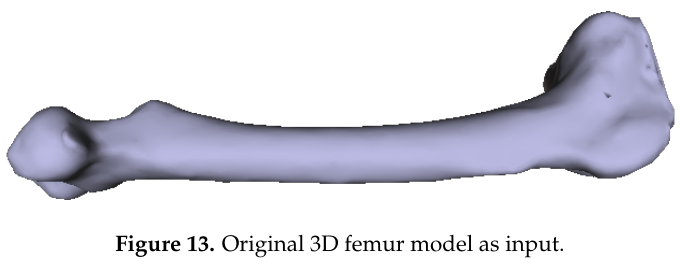
Figure 13. Original 3D femur model as input.